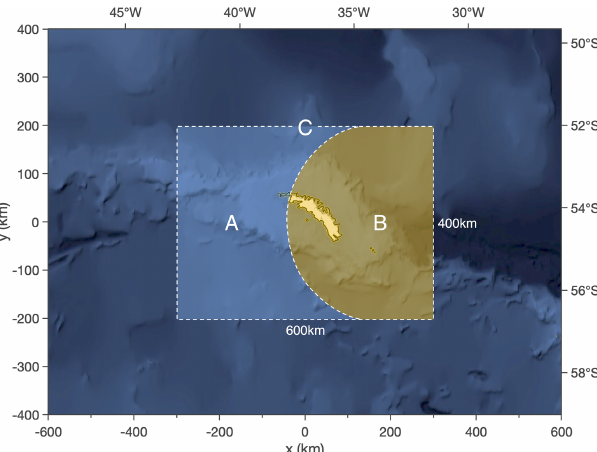
Figure 4. Illustration of the two regions to the east and west of South Georgia used to produce the values in Table 1. Region A is upwind of the island and region B is over and downwind of the island. The two regions have equal